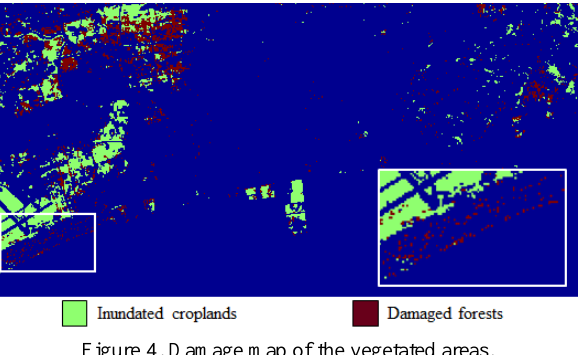
Figure 4. Damage map of the vegetated areas.